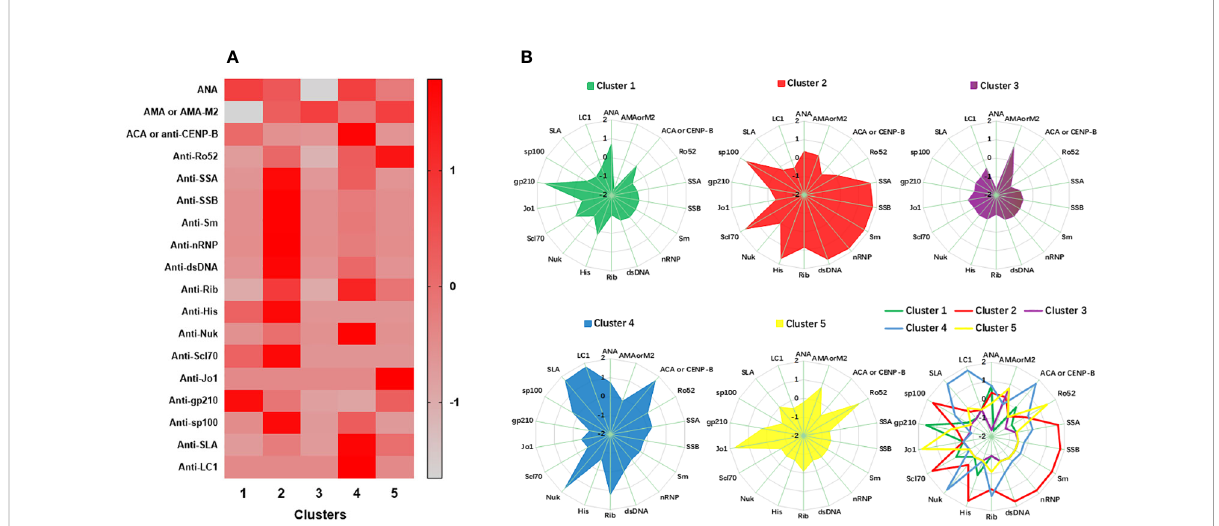
FIGURE 2 (A) Autoantibody clusters of patients with PBC in the study. Heatmap shows the Z Scores of the frequencies for each autoantibody by cluster. The scale on the right denotes Z Scores of antibody frequencies from grey (-2.0, low) to red (+2.0, high). Heatmap rows corresponding to clusters 1, 2, 3, 4 and 5 are indicated. (B) Radar plots shows the Z Scores of the frequencies for each autoantibody by cluster. For a given circle each radius represents Z Scores of each autoantibody frequency. Points at the center represent -2.0, whereas points at the perimeter represent